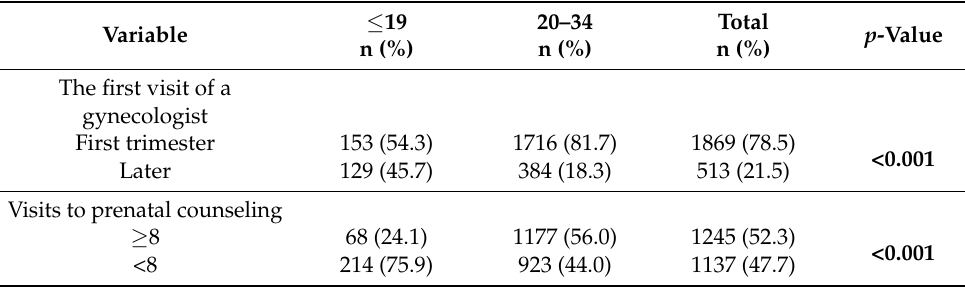
Table 2. Antennal care received by the respondents.